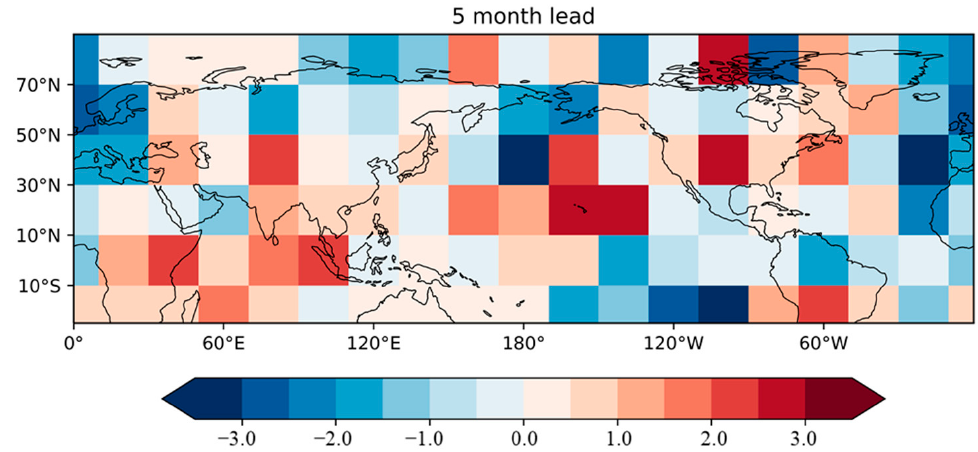
Figure 5. The heat map of the CNN from the 5-month lead time. Positive (negative) values represent how predictors contribute to the prediction of a positive (negative) NCDT.